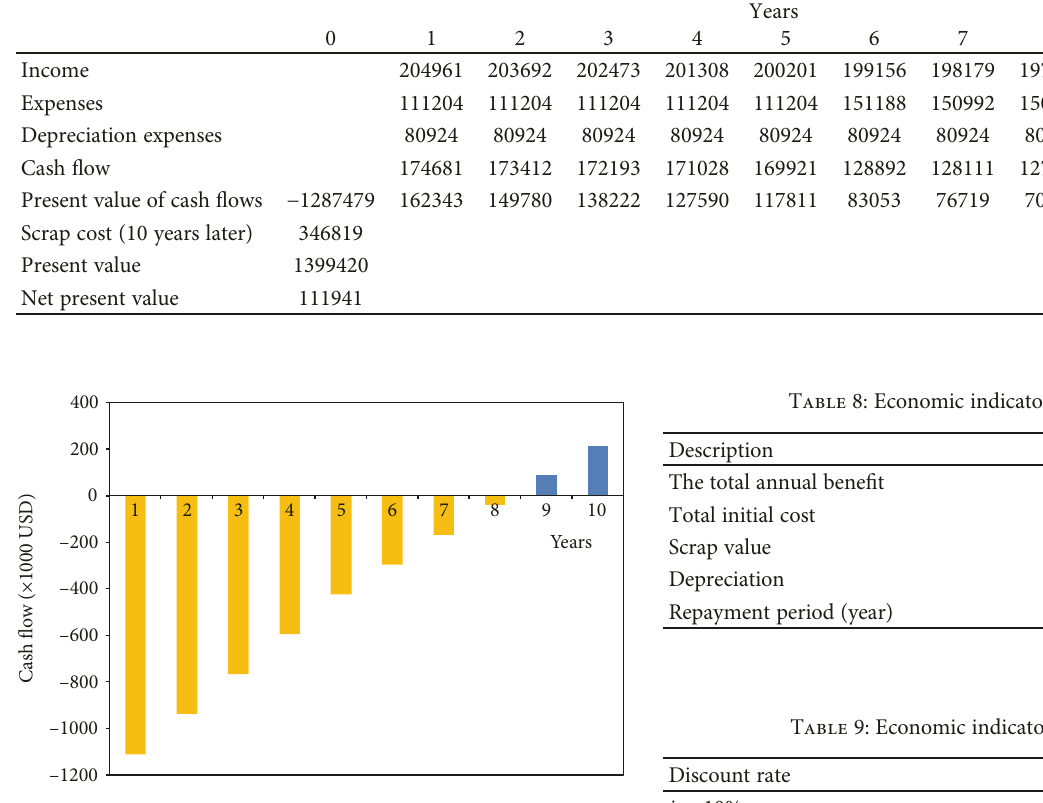
Figure 4: Cumulative cash fl ow, NPV for PV power